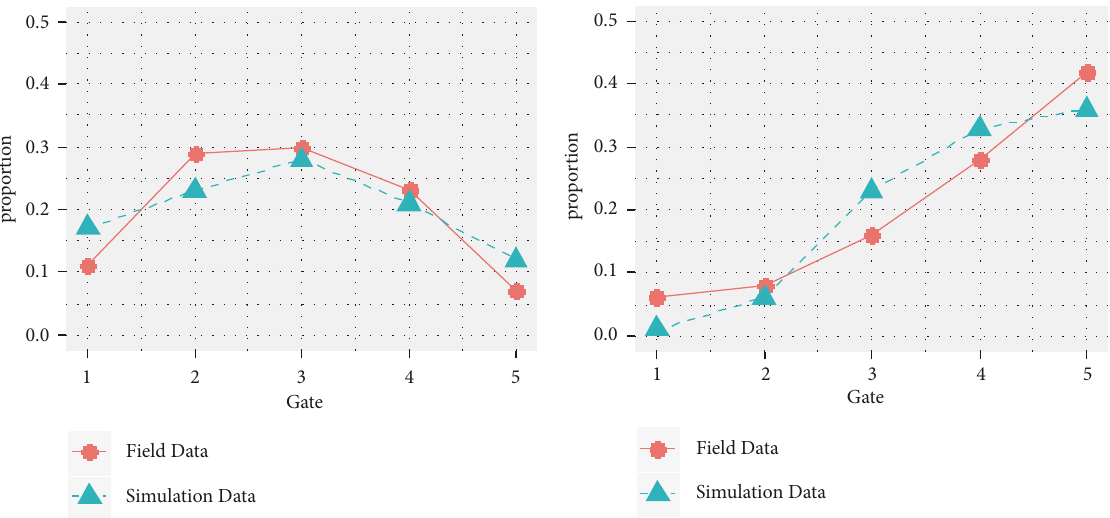
Figure 10: Comparison of simulation results and survey data under symmetric layout (left) and asymmetric layout (right).